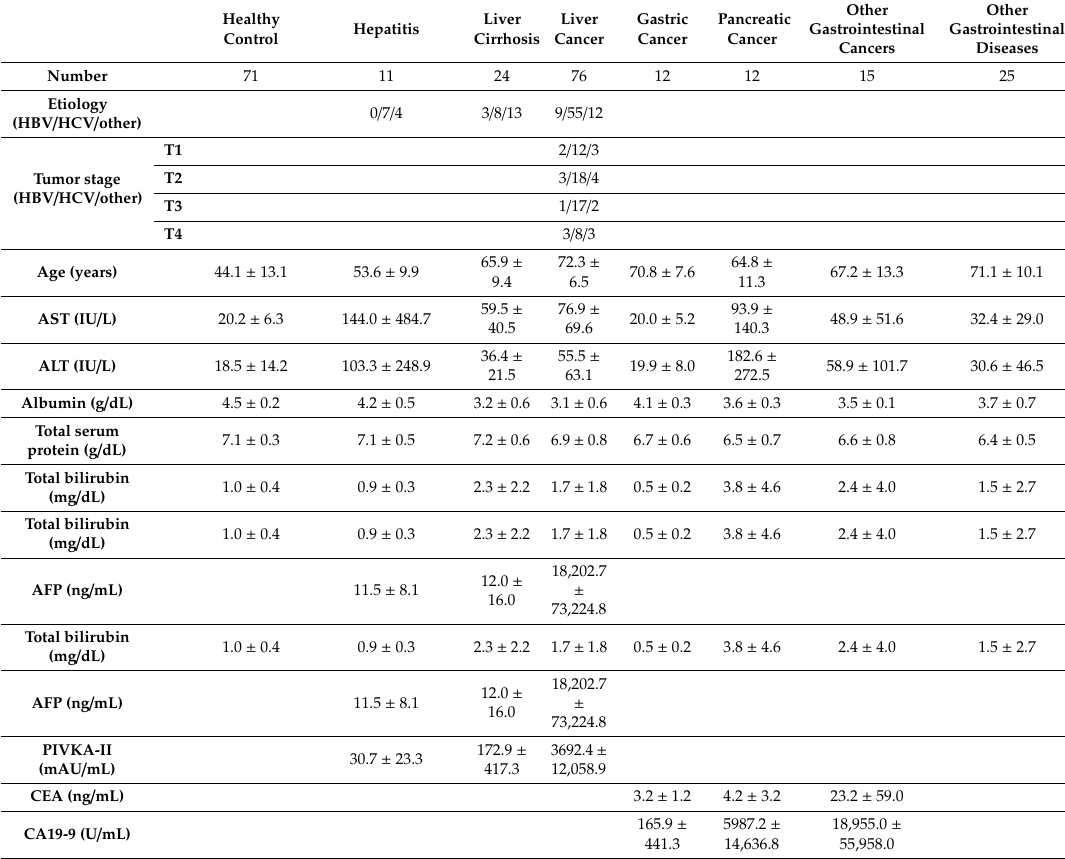
Table 1. Patient characteristics and serum expression levels of six N